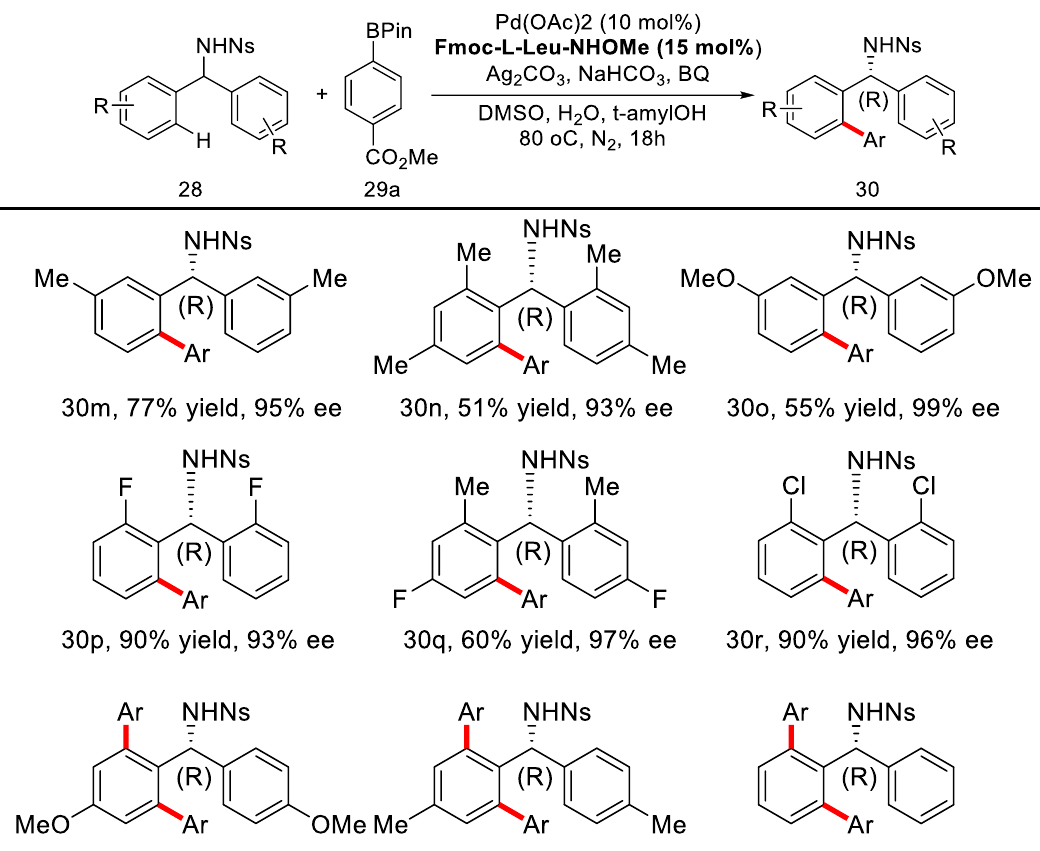
Scheme 22. Reactions with different diarymethylamines [78].